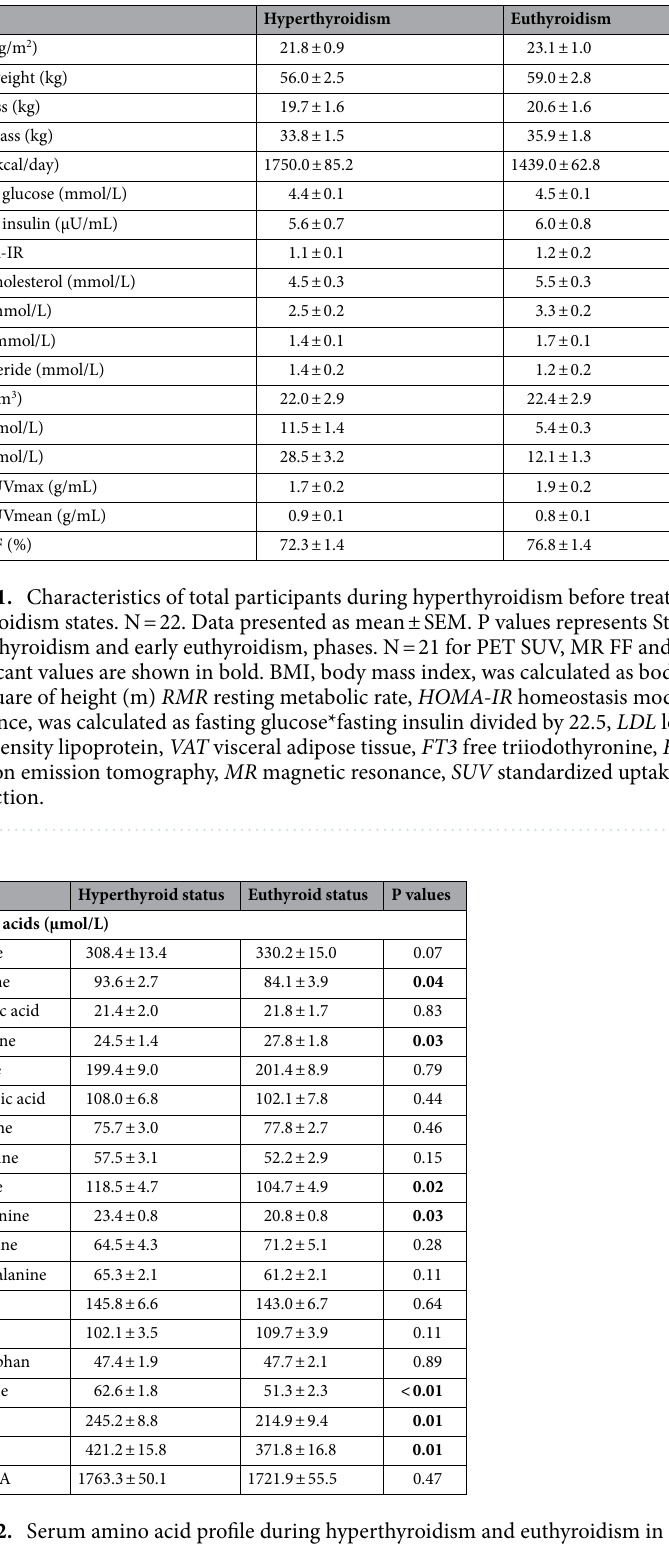
Table 2. Serum amino acid profile during hyperthyroidism and euthyroidism in participants with Graves’ disease. N = 22. Data presented as mean ± SEM. P values represents Student’s t -test between hyperthyroidism and early euthyroidism. Statistically significant values are shown in bold. BCAA branched-chain amino acids (isoleucine, leucine and valine), AA amino acids.